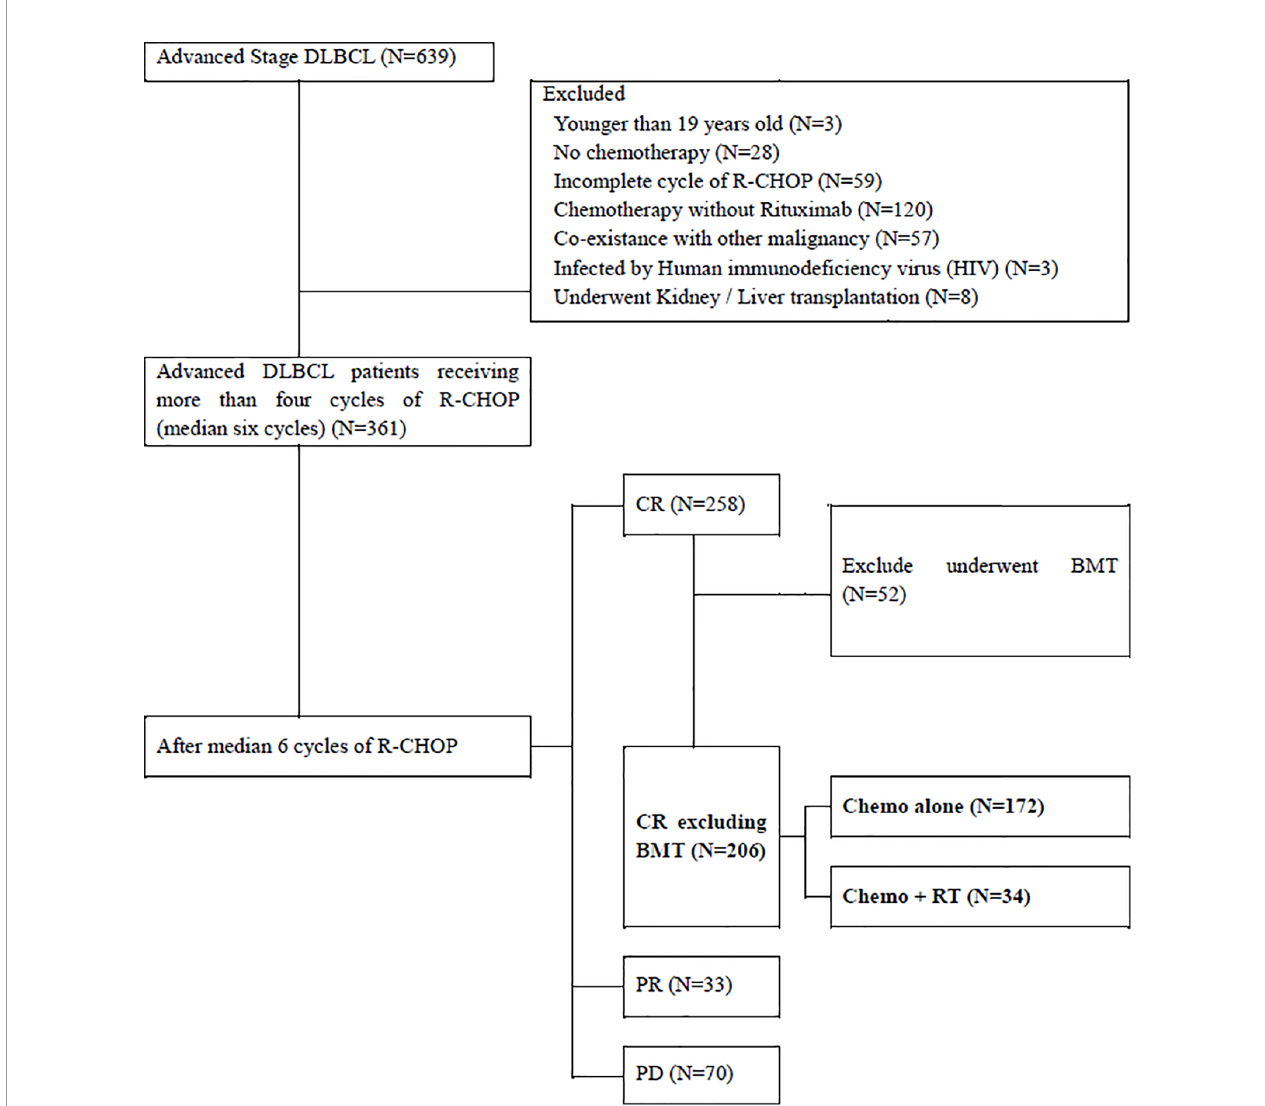
FIGURE 1 | Inclusion Criteria. DLBCL , Diffuse Large B-cell lymphoma; CNS , Cranial Nervous System; R-CHOP , rituximab combined with cyclophosphamide, doxorubicin, vincristine, and prednisone; CR , complete remission; BMT , bone marrow transplantation; PR , partial remission; PD , progressive disease; RT ,